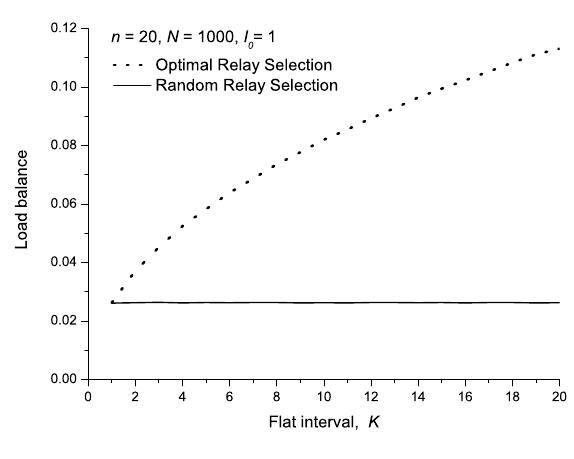
Figure 6. Comparisons between the load balance performance of protocol 1 and 2 , when n = 20 , N = 1000 and I